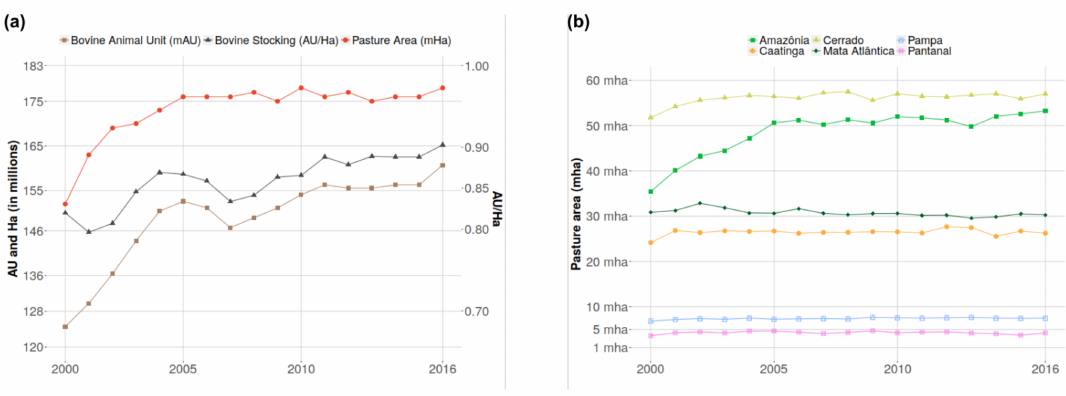
Figure 5. ( a ) Pasture area in Brazil, bovine animal unit (considering the composition and size of the herd) and Brazilian stocking rate time series; ( b ) Time series of the pasture areas in the six Brazilian